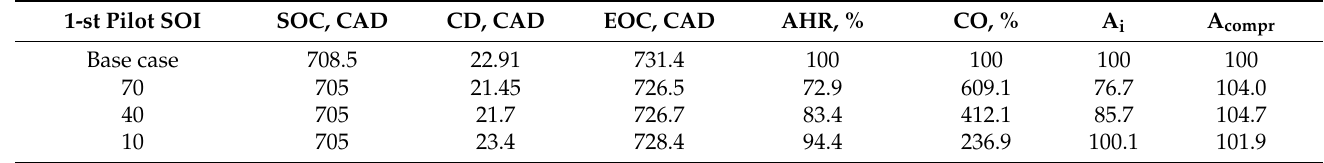
Figure 7. The first pilot SOI variable influence on combustion process and emissions. Table 2. Combustion parameters for the 2nd pilot SOI 45 CAD before TDC.